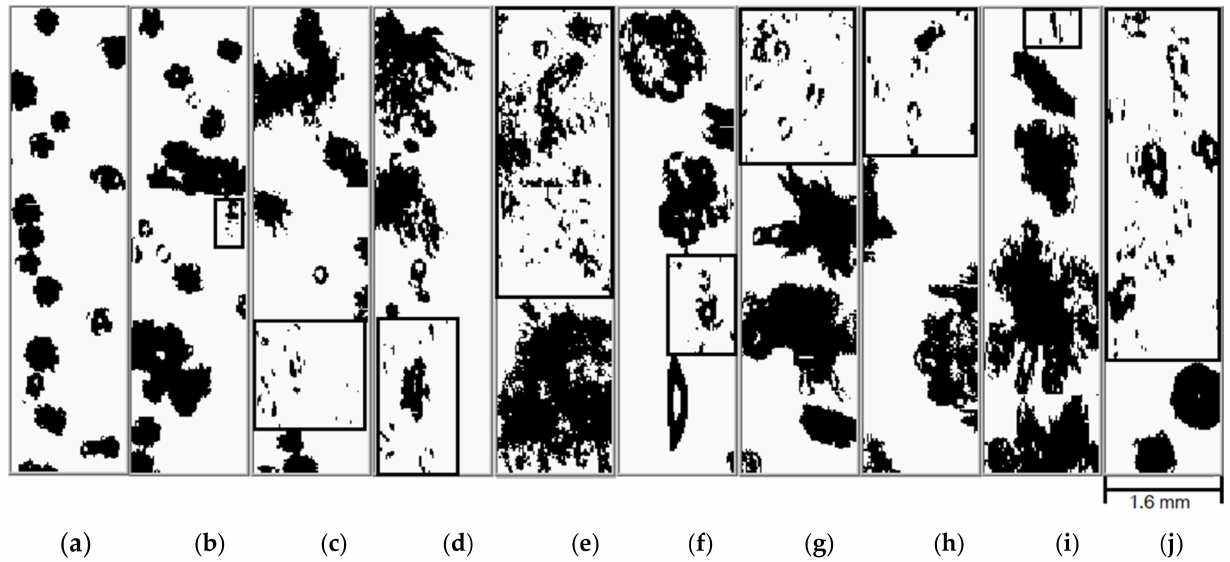
Figure 1. Cloud particle images measured by a CIP in the selected time; the shattered particles are highlighted in black boxes: ( a ) S1; ( b ) C1; ( c ) S2; ( d ) S3; ( e ) C2; ( f ) S4; ( g ) C3; ( h ) C4; ( i ) S5; ( j )